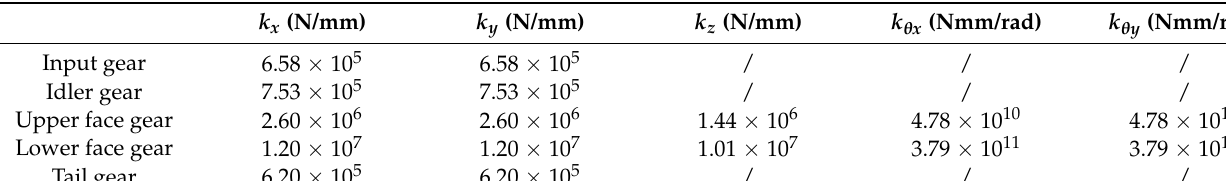
Table 2. The values of gear support stiffness.